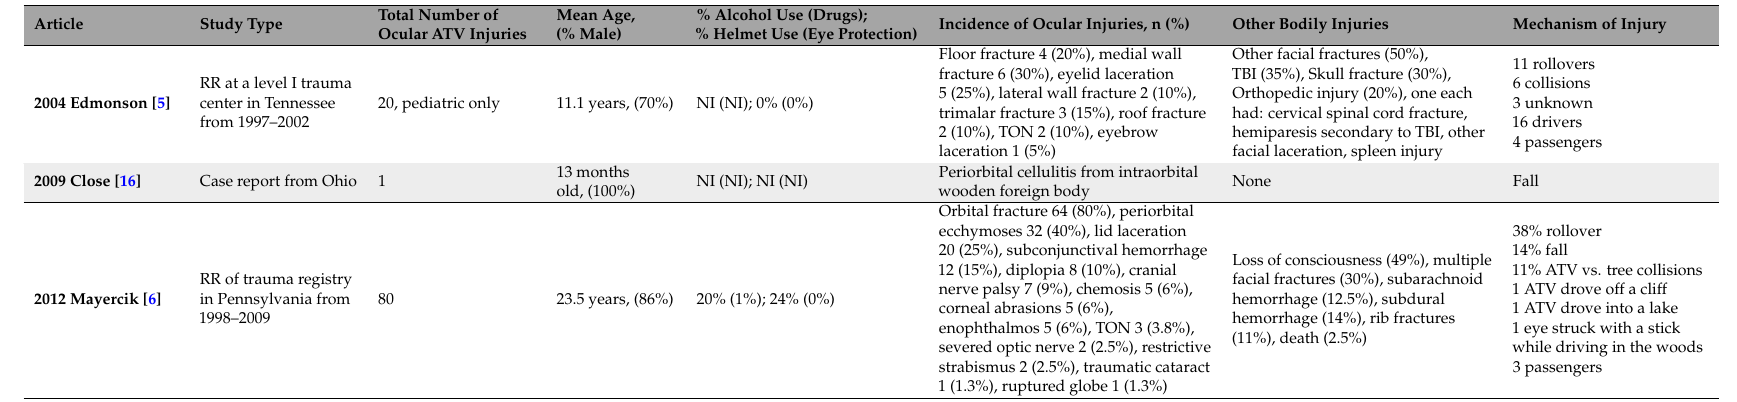
Table 1. ATV-related ocular injuries. RR: Retrospective review. TON: traumatic optic neuropathy. TBI: traumatic brain injury. NI: no